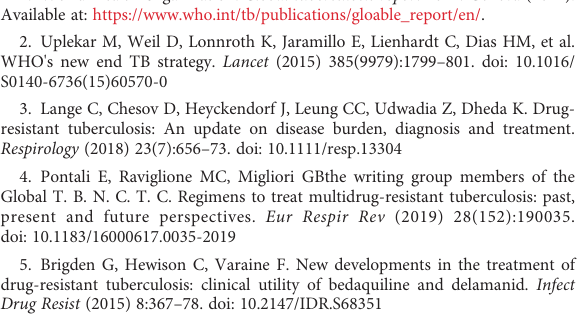
SUPPLEMENTARY FIGURE 8 Effect of DLM on JAK/STAT1 pathway in THP-1 cells. THP-1 cells were treated with DLM, DMSO, respectively, for 0-24 h. Western blot analysis was performed by using antibodies to p-JAK2, JAK2, p-STAT1, STAT1, respectively. b -actin was used as